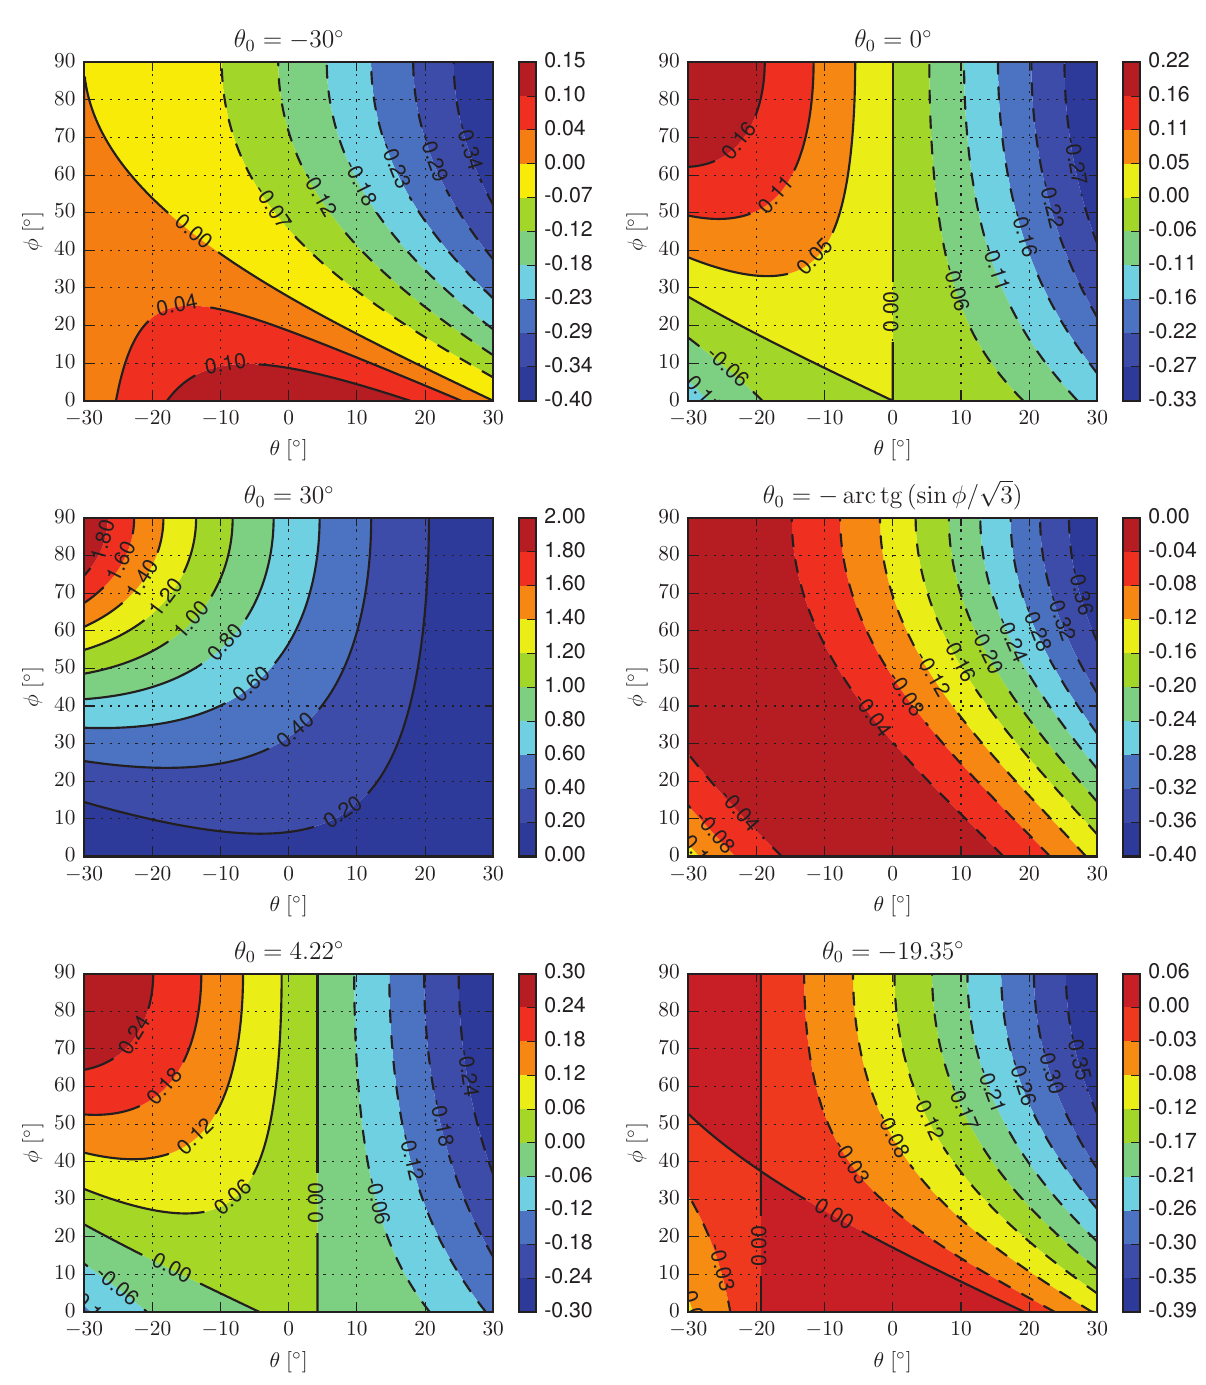
values with respect to Lode angle θ and friction angle ϕ 0